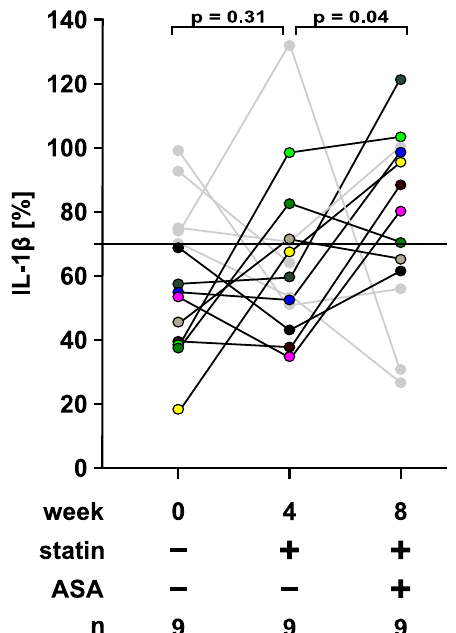
Figure 9. C-reactive protein (CRP)-mediated inhibition of the release of interleukin-1 β (IL-1 β ) by monocytes of patients suffering from low-grade coronary heart disease. Patient blood was drawn before lipid-lowering medication, after four weeks of statin intake and after another four weeks of combined treatment with statin and acetylsalicylic acid (ASA). IL-1 β was measured in cell culture supernatants of monocytes primed with lipopolysaccharide (LPS, 5 ng/mL, 3 h) and stimulated with 2 ′ (3 ′ )- O -(4-benzoylbenzoyl)adenosine 5 ′ -triphosphate (BzATP, 100 µM, 30 min) in the presence or absence of CRP (5 µg/mL). IL-1 β values obtained upon stimulation with BzATP were set to 100% and the values obtained in the presence of CRP were calculated accordingly. Data from patients who did not show a CRP-mediated inhibition of IL-1 β release below 70% are depicted in grey and were not included in the statistical analysis. Data are presented as individual data points; data from individual patients are symbolized by different colors; data points belonging to the same individual are connected by lines; bar represents median; whiskers encompass the 25th to 75th percentile. Experimental groups were compared by Friedman test followed by the Wilcoxon signed-rank test.